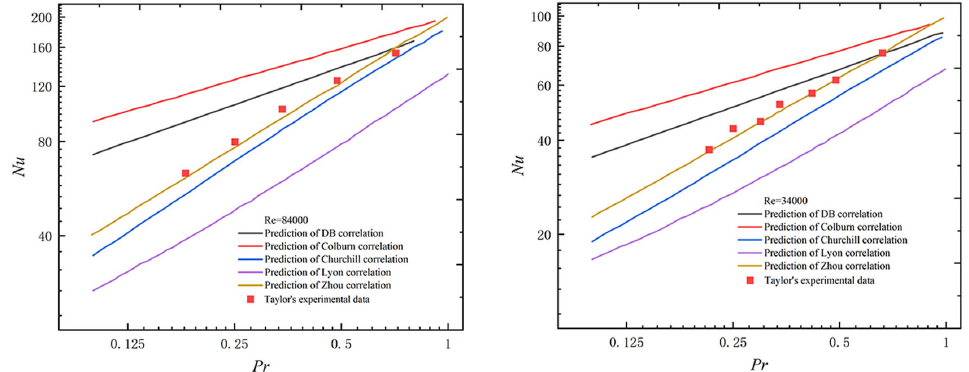
Figure 14. Validation of correlations applicable to different Prandtl number ranges [22].